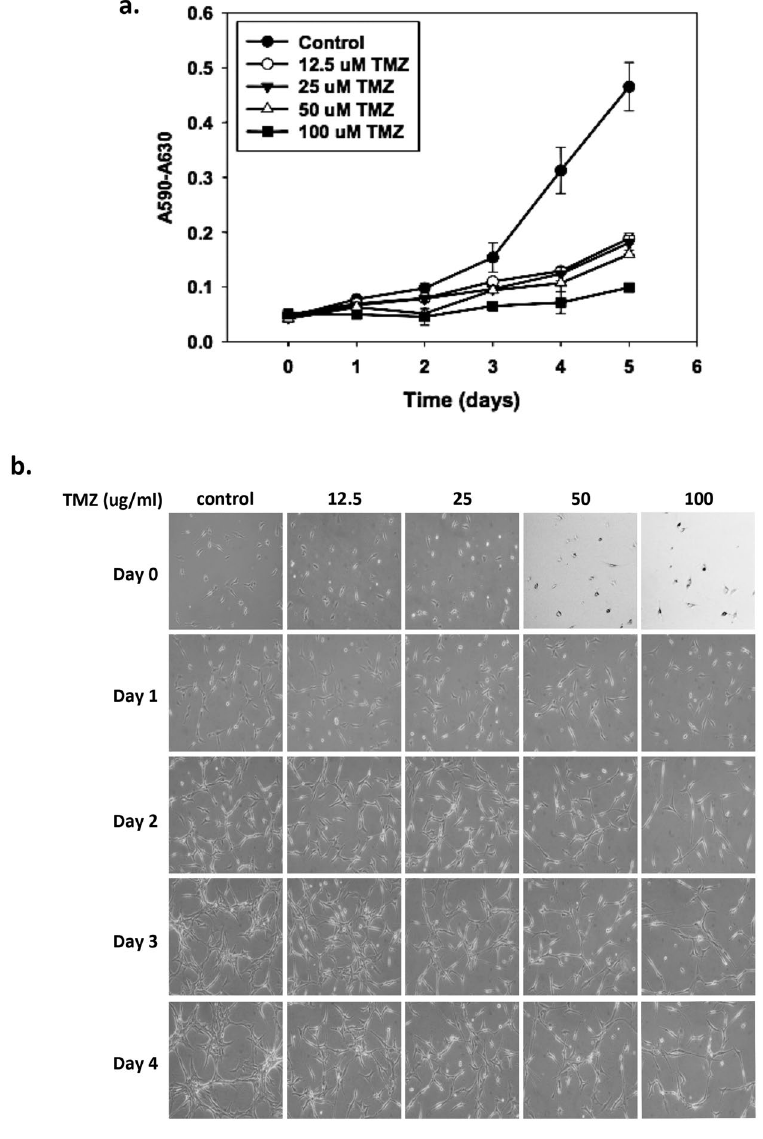
Figure 1. Dose and time-dependent effects on cell proliferation by TMZ in U87 cells. ( a ) The cell viability in various concentrations (– • –, control (DMSO only); – ○ –, 12.5 μ g/ml; – ▼ –, 25 μ g/ml; – △ –, 50 μ g/ml; – ■ –, 100 μ g/ml) of TMZ treated cells for different time frames: 0 day, 1 day, 2 days, 3 days, 4 days and 5 days. The data were means ± SD of four independent experiments. n = 3 ( b ) Morphology and cell density of U87 glioblastoma cell lines treated with or without vary concentration TMZ (0 μ g/ml, control; 12.5 μ g/ml; 25 μ g/ml; 50 μ g/ml; 100 μ g/ml) for 0–4 days. Scale bar = 10 μ